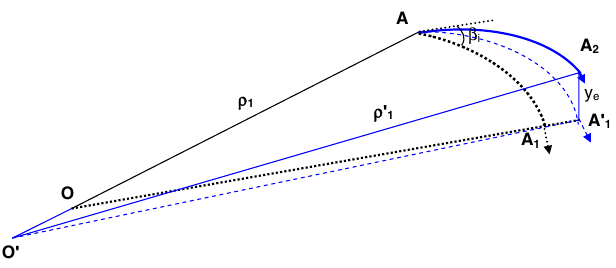
FIG. 2. Effect of initial nonzero vertical angle (cid:6) i on the path of particle inside a sector dipole